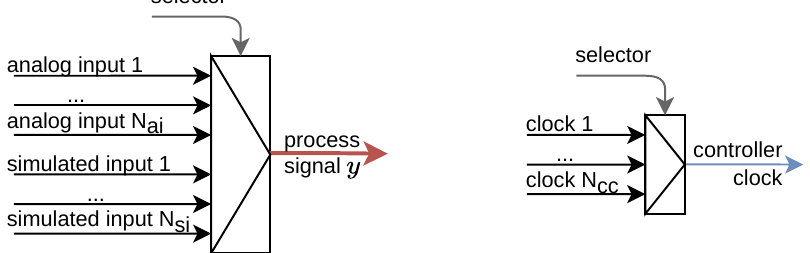
Figure 8. Selectors for input signals of the controller: process signal ( left ) and controller clock ( right ) in the considered system.